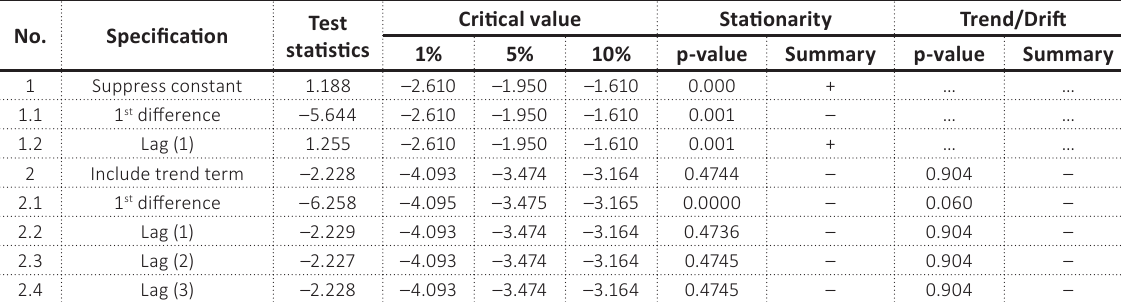
Table 2. Phillips-Perron test for unit root (USD/UAH official exchange rate)